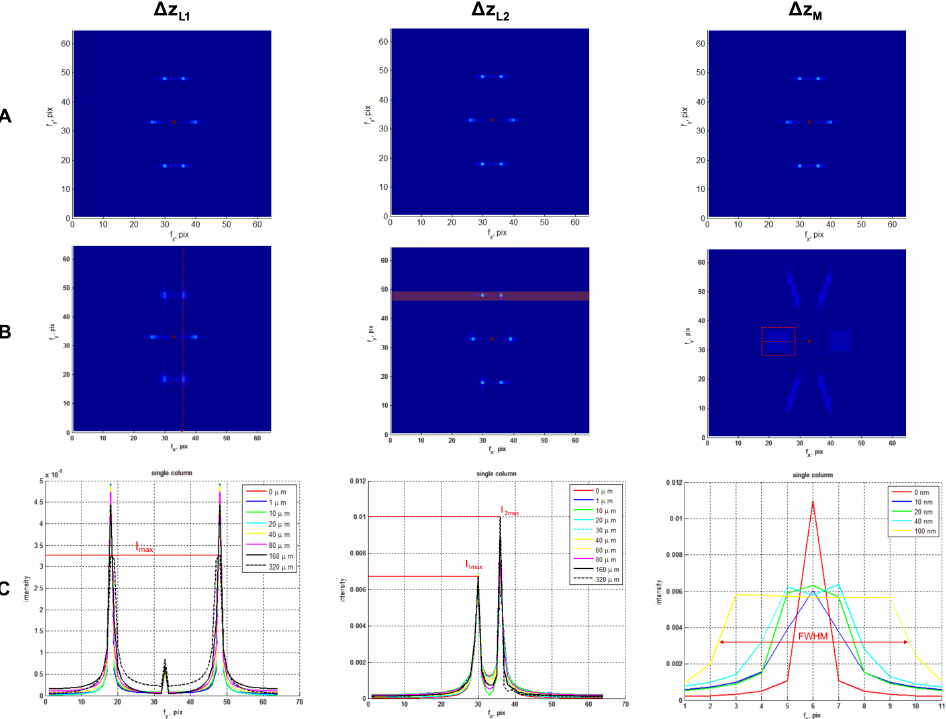
Figure 7. The interferogram post-processing scheme: ( A ) reference Fourier spectrum with 0 devia- tions; ( B ) distorted Fourier spectra generated with misplaced optical elements: ( C ) 1D section of the spectrum used for the metrics